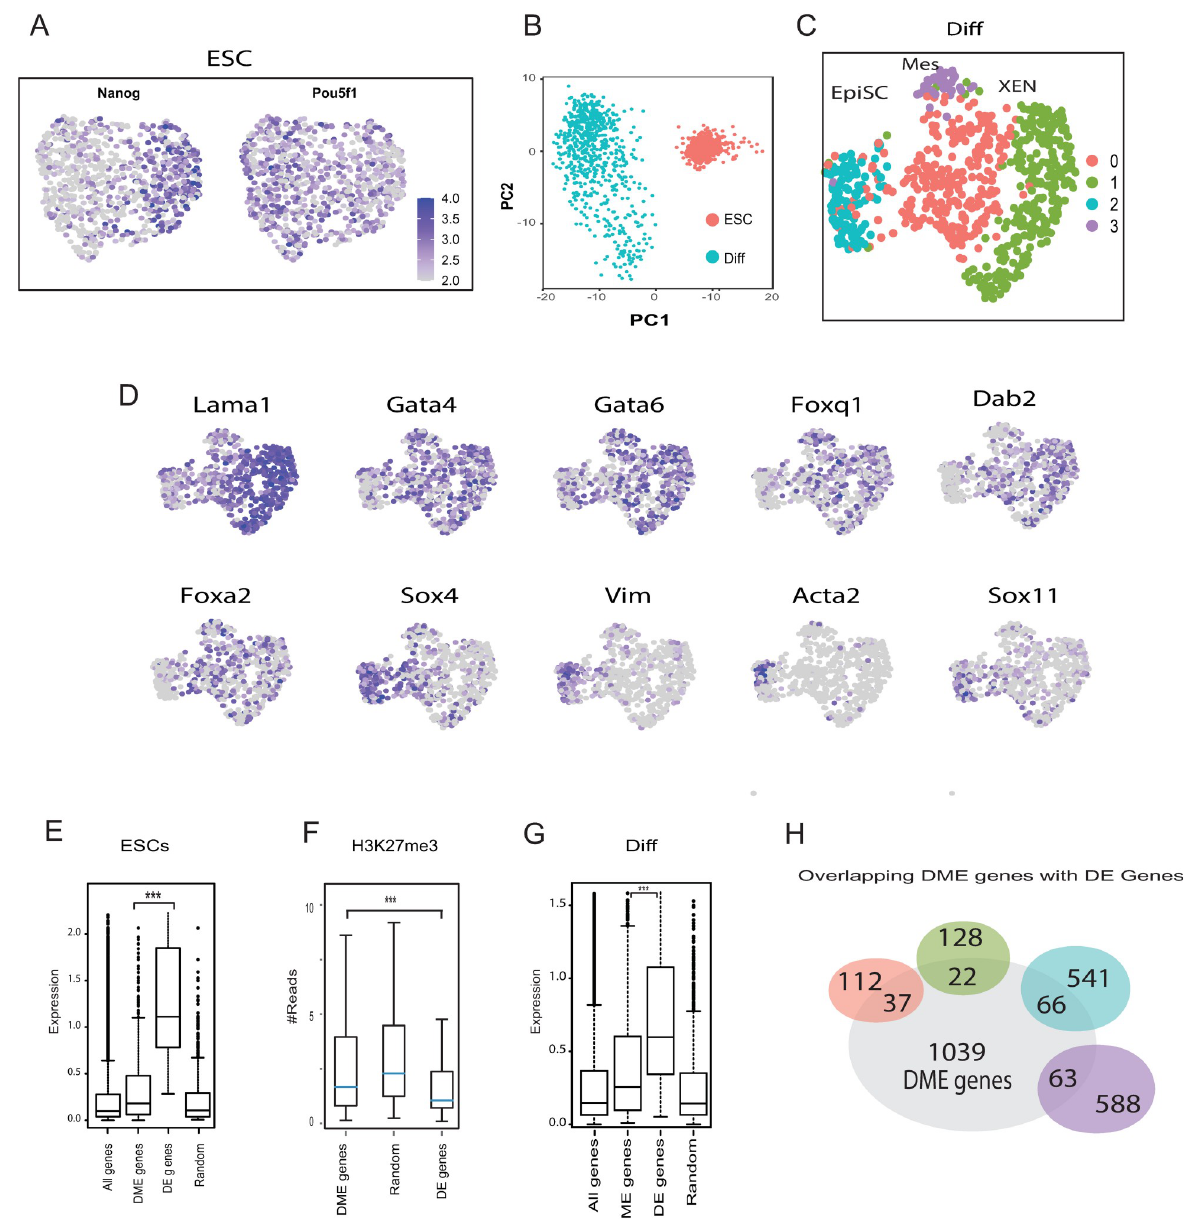
Fig 4. Single-cell RNA-seq indicates that DMEs regulate cellular heterogeneity. (A) Single-cell RNA-seq data from 869 ESCs was processed using the InDrop method. UMAP plots and unbiased k -means clustering revealed two subpopulations explained, mostly, by Nanog expression levels while Pou5f1 expression levels remained stable in most cells. Levels vary from low expression in gray to high expression in purple. (B) Single- cell RNA-seq data of ESCs and differentiated cells was subjected to principal component analysis. Distances between cells in the plot indicate similarities between transcriptional profiles. (C) Single-cell RNA-seq data from 696 differentiated cells was processed using the InDrop method. UMAP and unbiased k -means clustering revealed four differentiated subpopulations separated by color. Each dot represents an individual cell. Clusters 0 and 3 show upregulation of genes associated with mesendodermal progenitors. Cluster 1 has high levels of XEN cells markers. Cluster 2 shows EpiSC markers. (D) Expression levels of 10 representative genes shown by UMAPs of differentiated cells with low expression in gray to high expression in purple . (E) Boxplot of expression levels in ESCs of all genes, genes regulated by DMEs, differentially expressed genes (DE genes) revealed by single cell RNA-seq analysis and a random set of genes. DME genes and DE genes differ in expression levels (student’s t. test p < e -10 ). (F) H3K27me3 reads around TSS regions (1 kb on either side of the TSS) in ESCs, showing that genes regulated by DMEs and randomly selected genes are more repressed compared to DE genes (student’s t. test p < e -10 ). (G) Boxplot of expression levels in differentiated cells of all genes, genes regulated by DMEs and DE genes and a random set of genes. A significant difference in expression levels between DME genes and DE genes was found (student’s t. test p < e -10 ). (H) Illustration of the intersection between genes regulated by 1227 DMEs, and the four clusters of genes identified